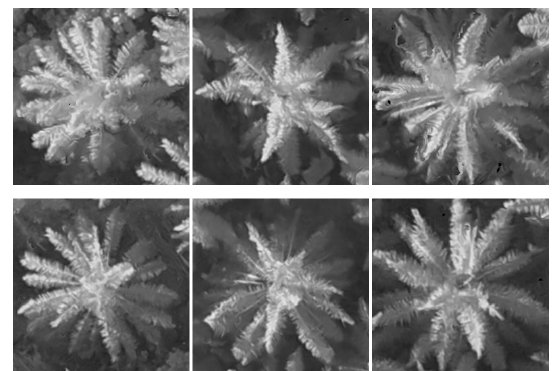
Figure 7: Few examples of positive samples (Palm) of training data in the red channel.